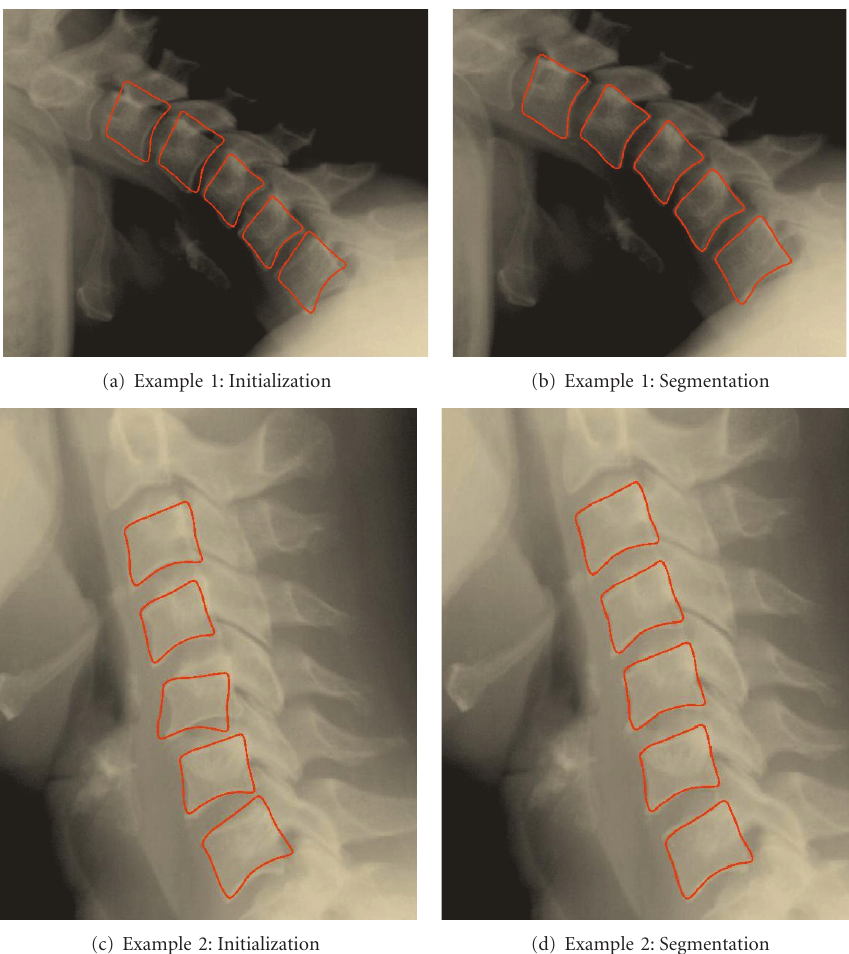
Figure 16: Results of segmentation using the vertebra